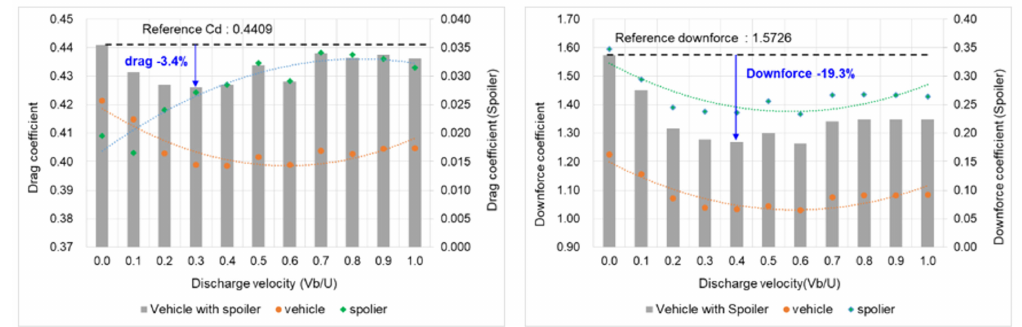
Figure 14. Comparison of aerodynamic coe ffi cients flow when is discharged at 0.50C at a vehicle driving speed of 300 km /